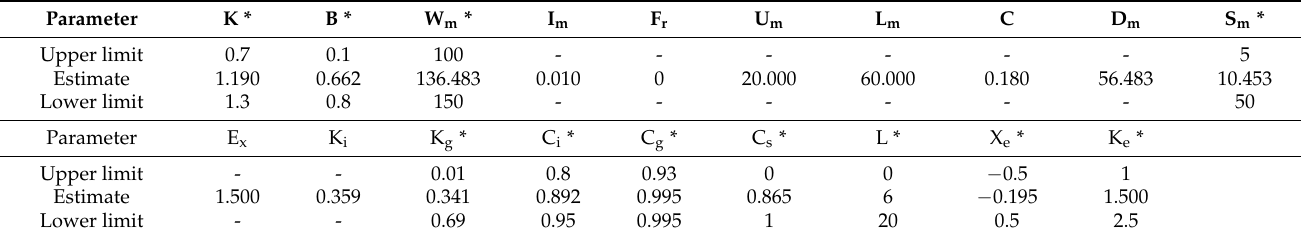
Table 1. Prior limits and optimal estimates of the XAJ model parameters.